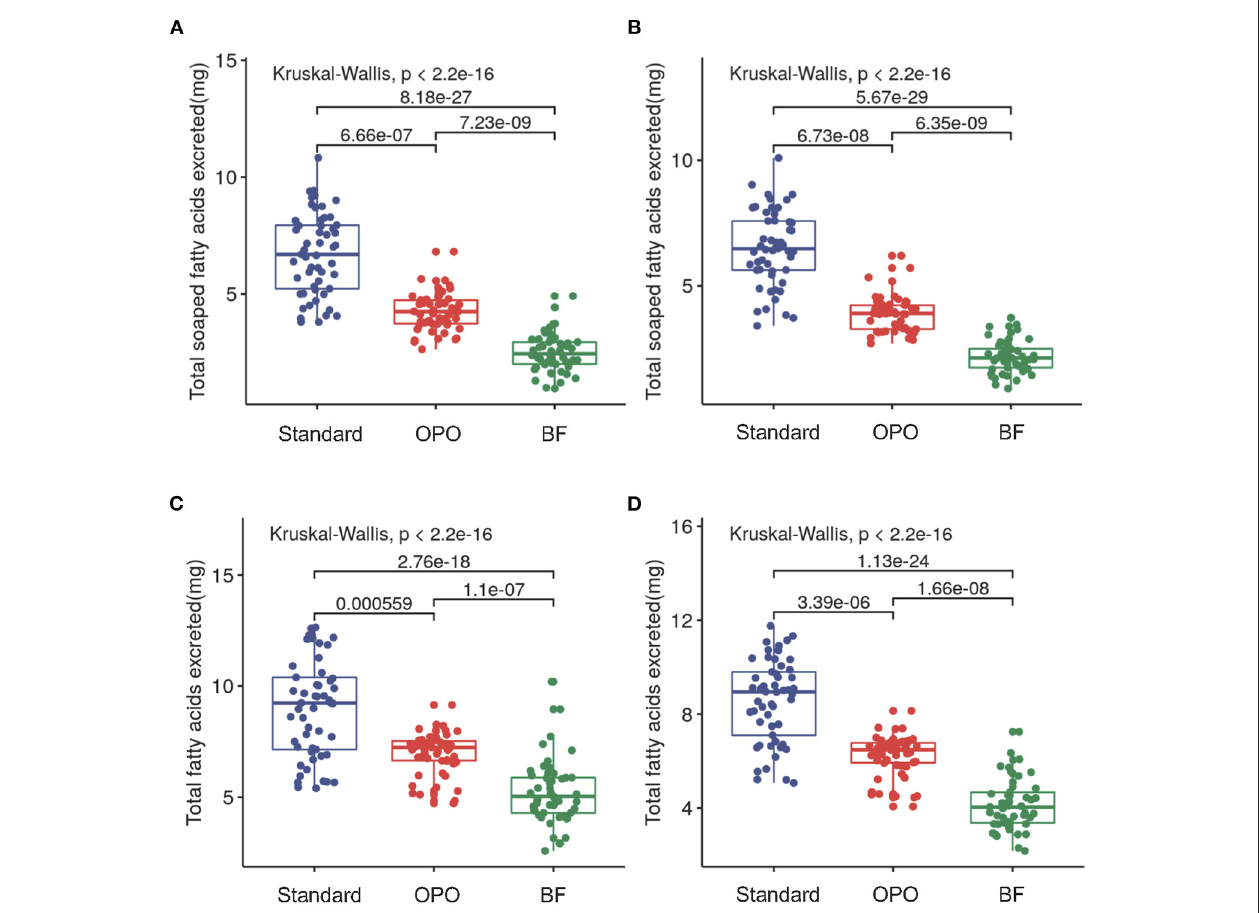
FIGURE 2 | Comparison of fecal saponified fatty acids and total fatty acids among the three study groups after feeding. (A) Concentrations of fecal saponified fatty acids at week 6. (B) Concentrations of fecal saponified fatty acids at week 12. (C) Concentrations of total fatty acids at week 6. (D) Concentrations of total fatty acids at week 12. Data are presented as the mean (range). A p -value of less than 0.05 was considered statistically significant.